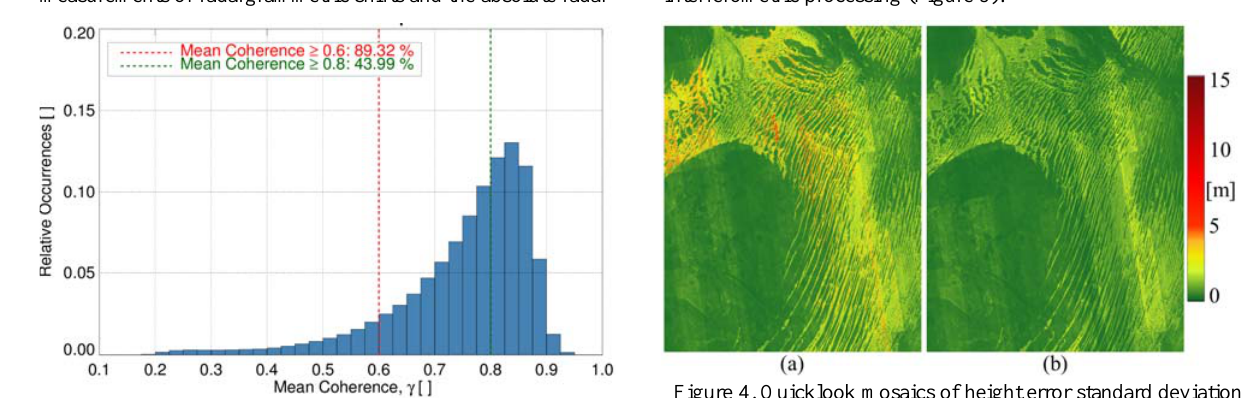
Figure 3. Histogram of mean coherence of land per scene. The red and the green dotted line give the relative occurrence of coherence over 0.6 and 0.8, respectively (February 2015)